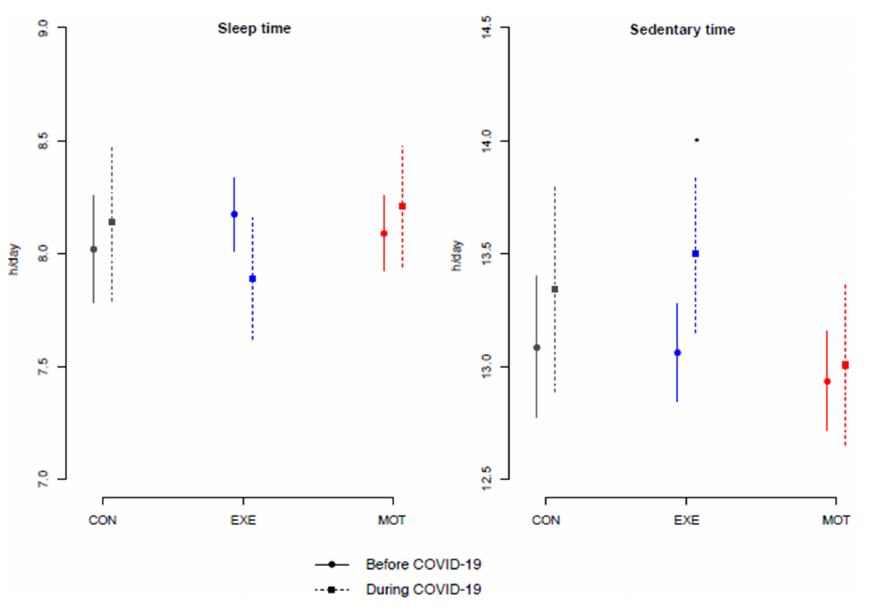
Figure 4. Average and 95% confidence interval of total sleep time and sedentary time before COVID- 19 [physical intervention only, participants ( n = 120) started and finished the intervention before